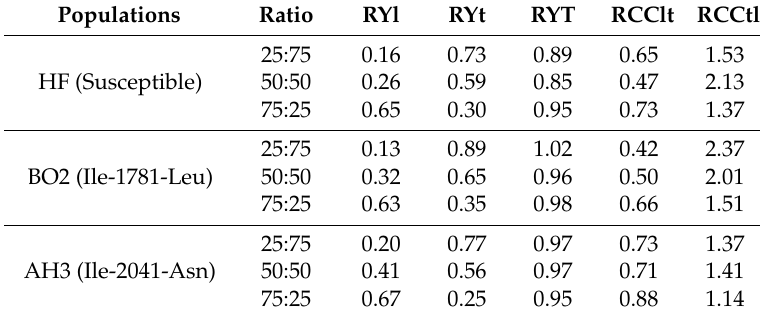
Table 3. Comparison of relative yield total (RYT) and relative crowding coefficient (RCC) based on shoot dry weight of T. aestivum and L. rigidum (S and R populations) in different ratios of sowing L. rigidum and T.